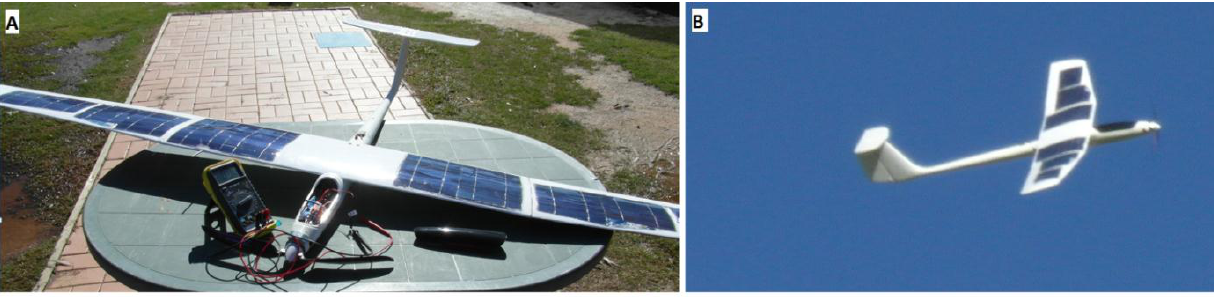
Figure 16. ( A ) Final configuration of the solar UAV; ( B ) aerial photography of the aircraft